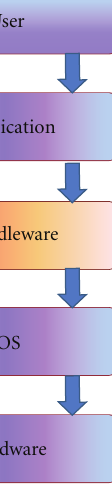
Figure 1: Middleware